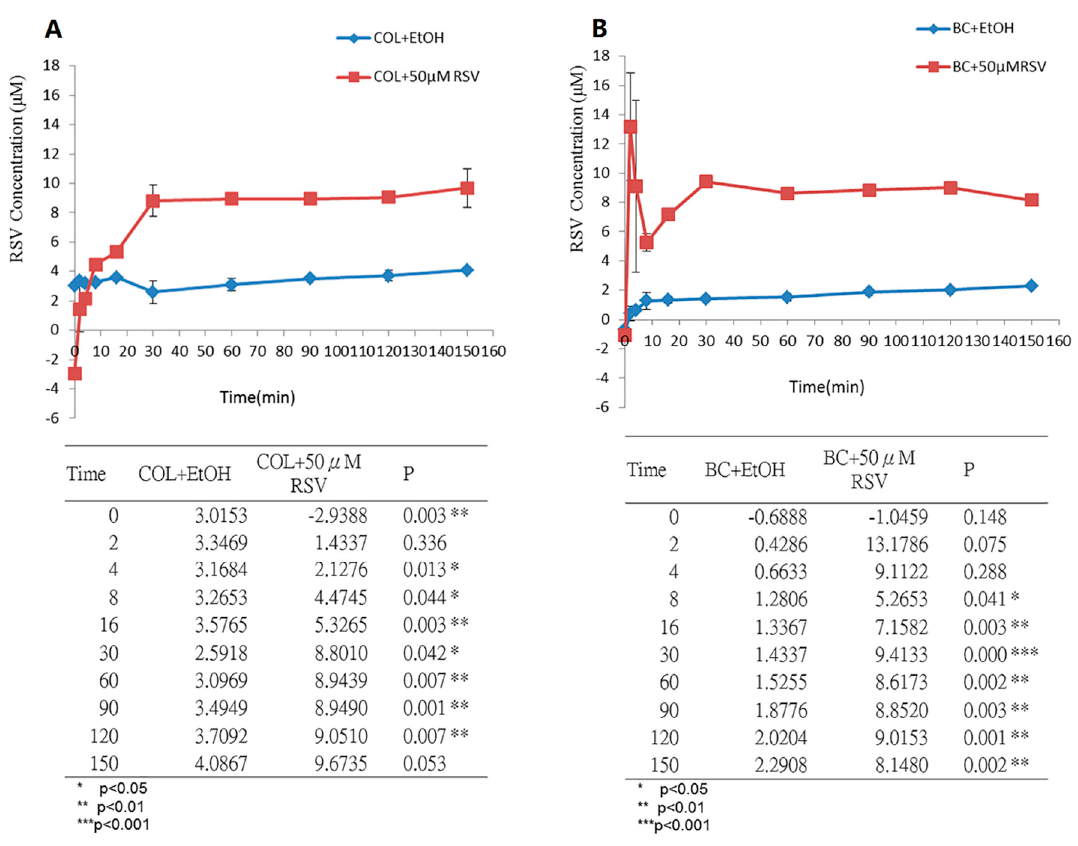
Figure 4. Monitoring RSV release from biomaterials in artificial saliva solution at 37 °C. ( A ) BC/RSV scaffold and ( B ) COL/RSV scaffold.